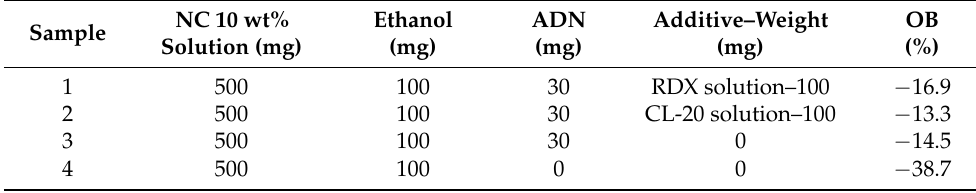
Table 1. The components of each